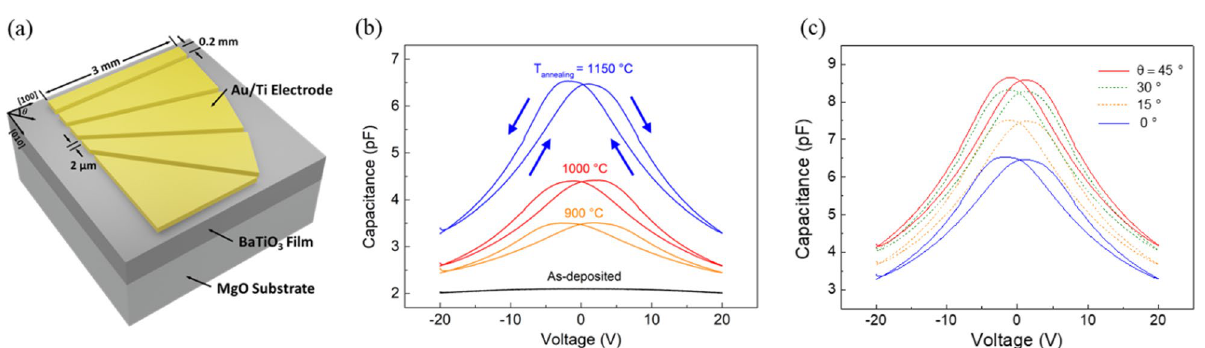
Figure 5. ( a ) Schematic image of Au/Ti coplanar electrodes on BTO film. Electrode with θ = 0° was aligned to MgO [100] direction and each channel between electrodes was aligned at 0, 15, 30, and 45° to MgO [100] direction. ( b ) Capacitance–voltage (C–V) curves of BTO film at different post-annealing temperatures (T annealing ; 900, 1000, and 1150 °C) measured with a coplanar electrode parallel to the MgO [100] direction. The direction of voltage sweep (indicated by arrows) is from −20 to 20 V and then from 20 to −20 V. ( c ) Capacitance–voltage curves of BTO film annealed at 1150 °C with electrode angles ( θ ) of 0, 15, 30 and